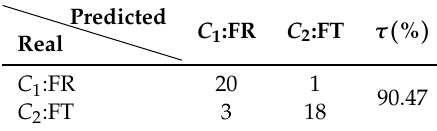
Table 2. The confusion matrix corresponding to the proposed Kohonen two class classification method. τ ( % ) corresponds to the classification accuracy. Predicted C 1 :FR C 2 :FT τ ( % ) Real C 1 :FR